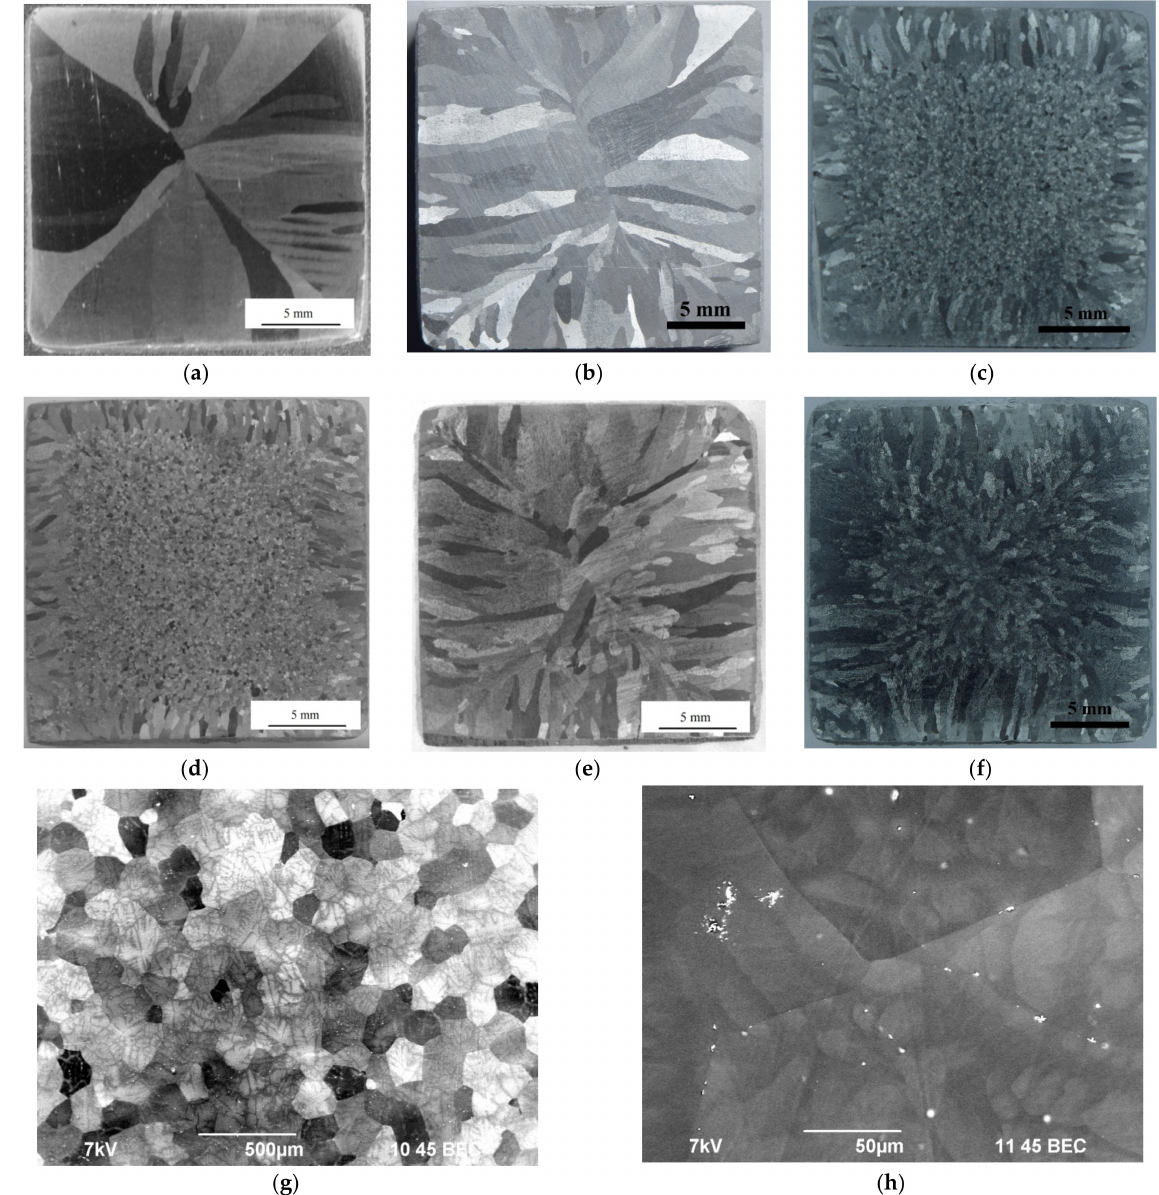
Figure 2. The microstructure of the cast alloys: ( a ) Alloy #1; ( b ) Alloy #2; ( c ) Alloy #3; ( d ) Alloy #4; ( e , g , h ) Alloy #5; and ( f ) Alloy #6. ( g ) The microstructure in the center of the bulk for Alloy #4; ( h ) the Al 3 Zr particles nucleated in the center of the bulk for Alloy